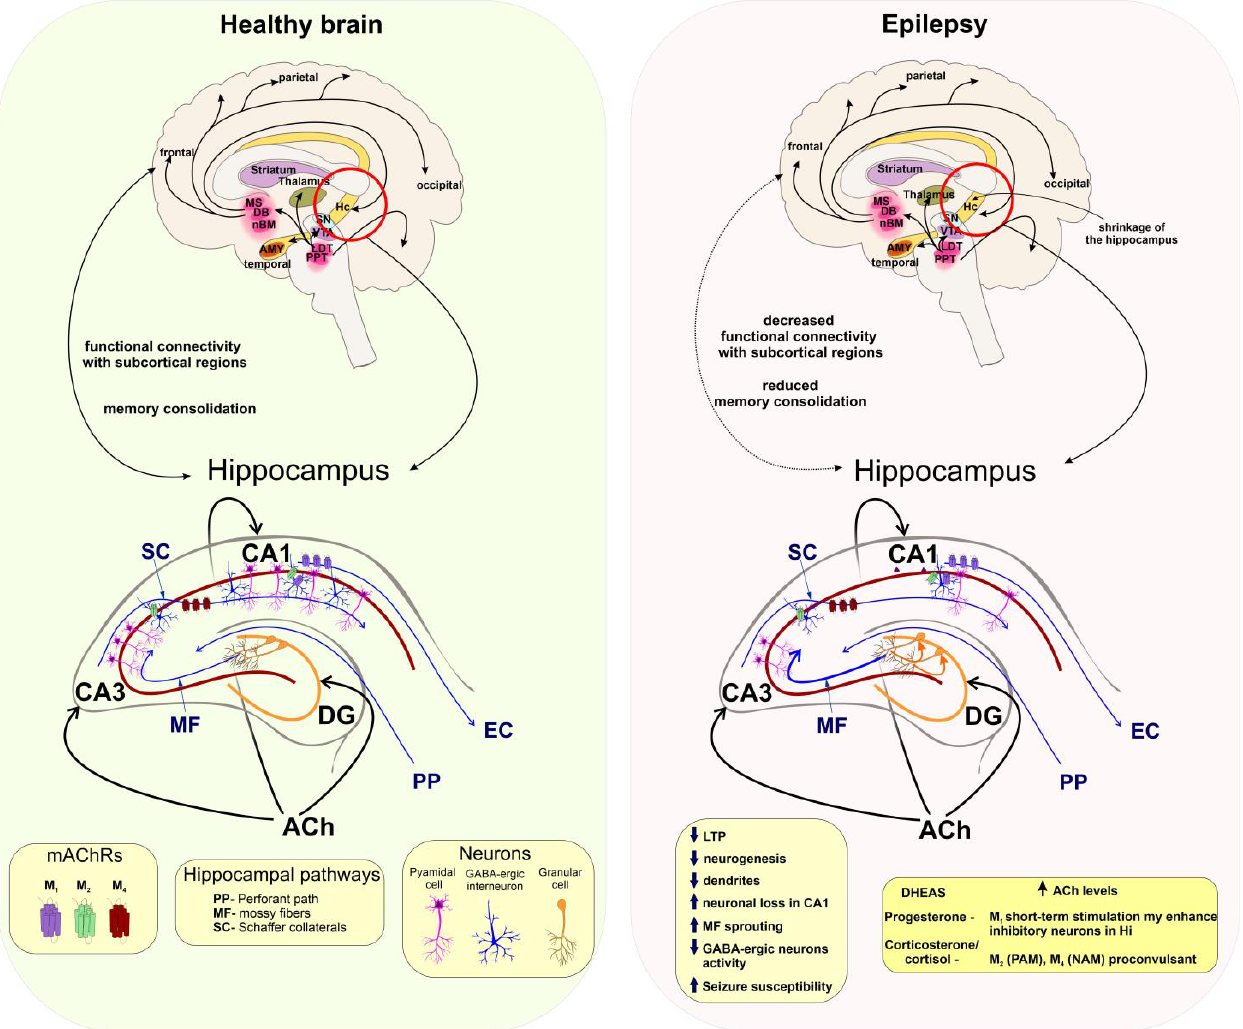
Figure 4. Cholinergic projections in the brain and hippocampal circuit in health and epilepsy. Left : In the healthy brain, cholinergic neurotransmission provides functional connectivity between the neocortex and hippocampus (Hc) and thus supports memory consolidation. In the Hc, Ach maintains a balance between excitation and inhibition within neuronal pathways involved in learning and memory (see Figure 2). Cholinergic projections regulate Hc activity within the dentate gyrus (DG), CA3, and CA1 regions of the Hc and M 1 receptors (purple) regulate excitability mainly of the pyramidal neurons (pink) and are also expressed on GABA-ergic interneurons (blue) in the CA1. The M 2 receptors (green) are expressed mostly presynaptically on GABA-ergic interneurons and their activation supports the CA1 excitability. The M 4 receptors on are expressed on glutamatergic neurons of SC and their activation decreases the activation of CA1. Right: In the epileptic brain, Hc circuits are affected by MS sprouting and increased excitability within DG granule cells. Mossy fibres (MF) send more projections to the CA3 and further increases Hc excitability and seizure susceptibility. These eventually lead to neuronal loss in the CA1 and impairment of Hc functions. Short-term stimulation of M 1 expressed on interneurons may reduce excitability within CA1. M 4 PAMs may inhibit overactive SC and thus CA1 activity. According to [45].